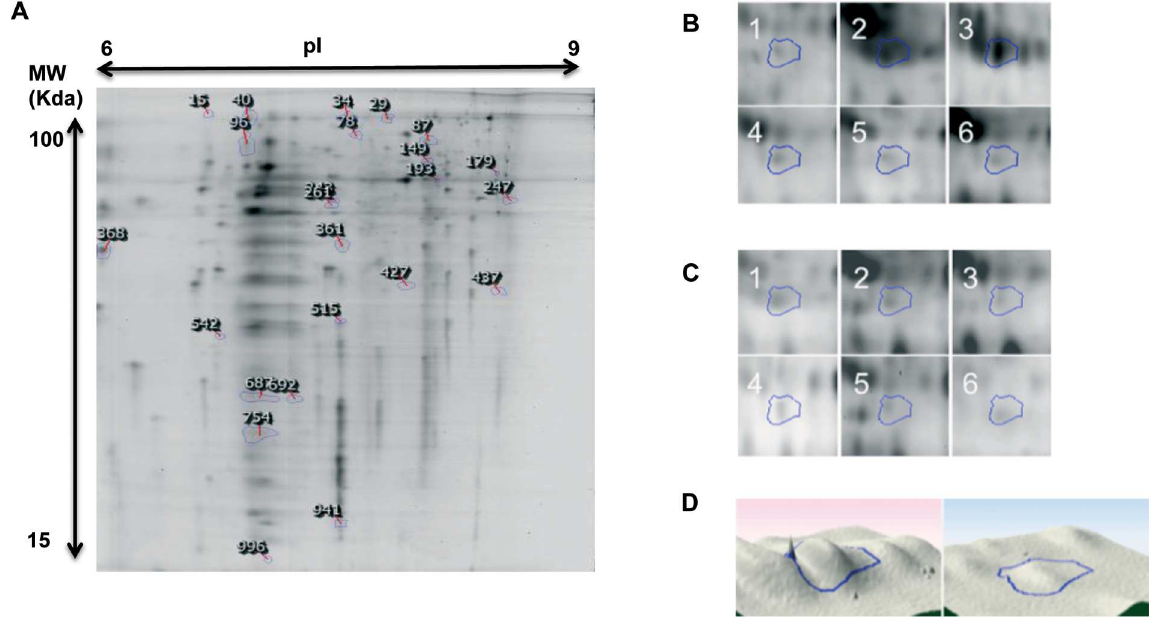
Fig 3. Example of a 2D-DIGE image (pI 6–9) depicting differences in protein abundance between sarcoidosis and healthy control spleen